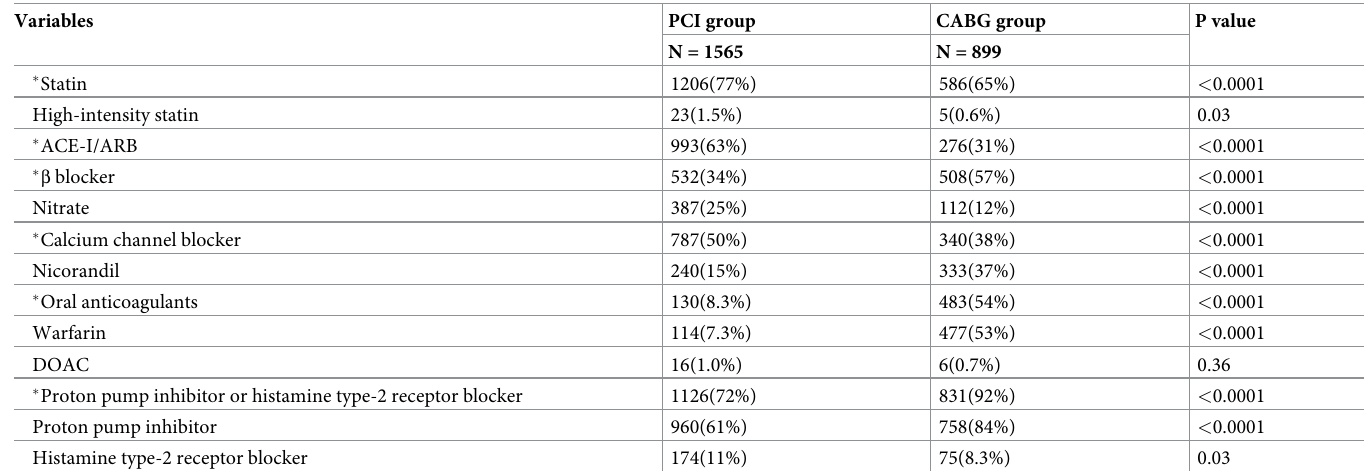
mellitus, prior heart failure, prior myocardial infarction, peripheral vascular disease, eGFR < 30 mL/min/1.73m 2 without hemodialysis, and hemodialysis (Table 1). As for the angio- graphic and procedural characteristics, the CABG group had greater number of target lesions or anastomoses and higher coronary anatomical complexity as indicated by the greater num- ber of targets for chronic total occlusion and higher prevalence of triple-vessel disease. Intra- coronary imaging, predominantly intravascular ultrasound (IVUS), was used in 87% of patients in the PCI group. Complete revascularization was more frequently achieved in the CABG group than in the PCI group (84% versus 68%, P < 0.0001); All the patients with two- vessel disease underwent complete revascularization in both groups, while complete revascu- larization was achieved much more frequently in the CABG group than in the PCI group (81% versus 39%, P < 0.0001) (Table 2). In terms of baseline medications, statins and angiotensin converting enzyme inhibitor/angiotensin II receptor blockers were more often prescribed in the PCI group than in the CABG group, while β blockers were more often prescribed in the CABG group than in the PCI group. The prevalence of high-intensity statins therapy was very low in both groups. Thienopyridines were prescribed in 194 patients (22%) in the CABG group, but were discontinued before the index procedure in 118 patients. Oral anticoagulants were more often prescribed in the CABG group than in the PCI group, mainly because atrial fibrillation was newly identified after the index procedure in 187 patients (21%) in the CABG group (Table 1).